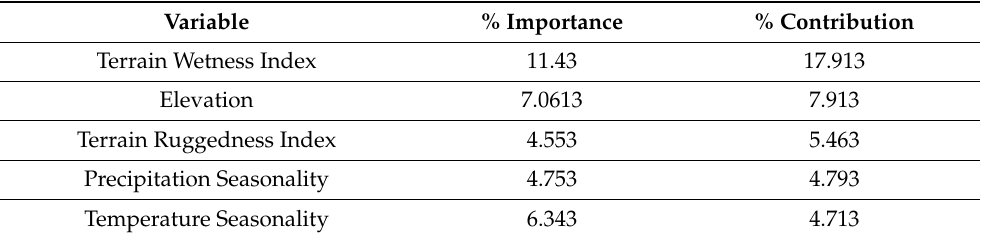
Table 1. Top five Mean Environmental Variables contribution and importance of derived Max- Ent models.